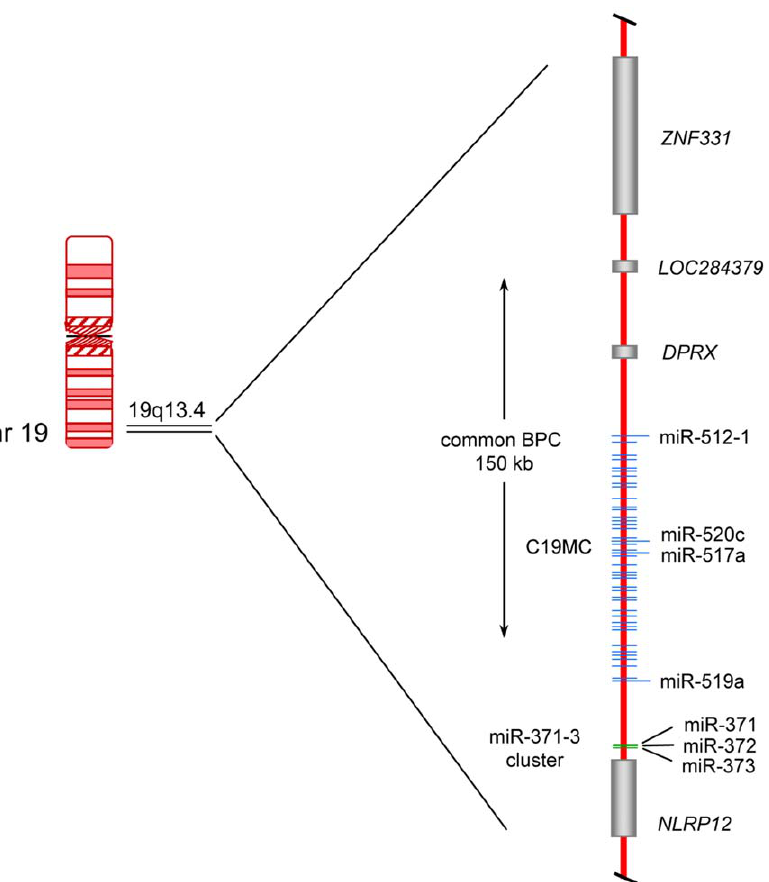
Figure 1. Scheme of the chromosomal region 19q13.4 with the two miRNA clusters C19MC and miR-371-3. Protein coding genes are represented by gray bars whereas genes of miRNA clusters are given as blue (C19MC cluster) and green (miR-371-3 cluster) lines, respectively. The common breakpoint cluster (BPC) of benign thyroid tumors of about 150 kb is indicated by a vertical arrow. miR-512-1 (pre-miR) is coding for mature- miR-512-5p, miR-371 (pre-miR) is coding for mature-miR371-3p. Gene symbols refer to the following protein coding genes: ZNF331 = zinc finger protein 331 , DPRX = divergent-paired related homeobox , NLRP12 = NLR family , pyrin domain containing 12.